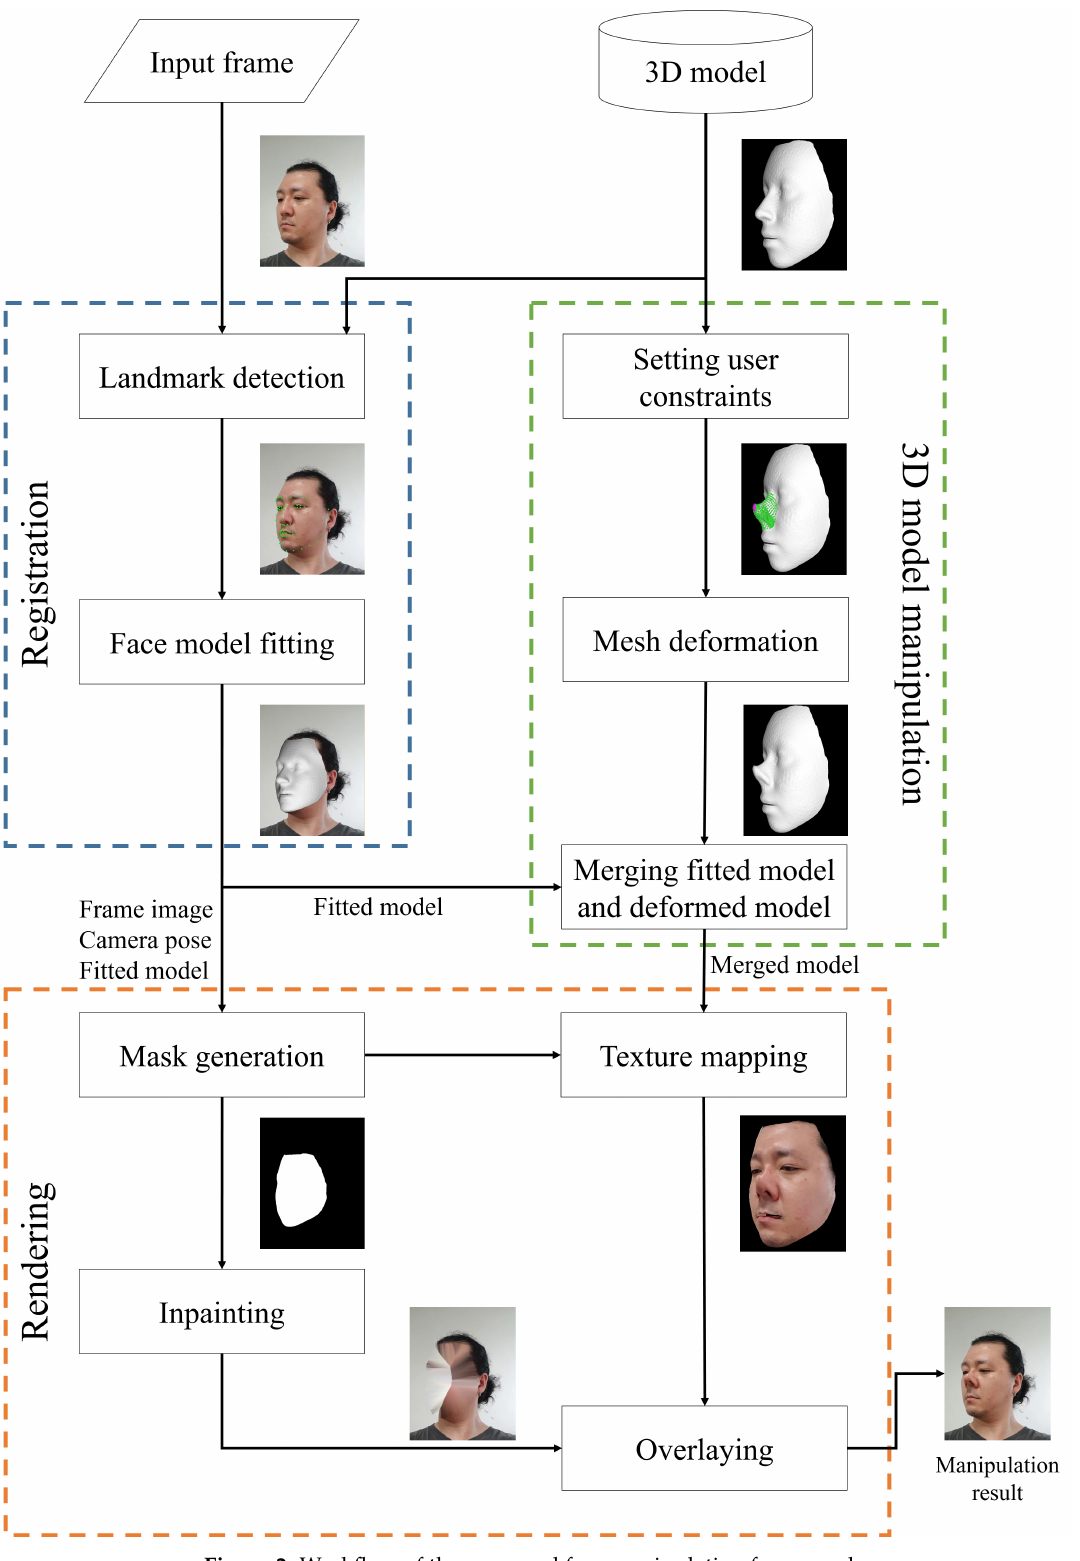
Figure 2. Workflow of the proposed face manipulation